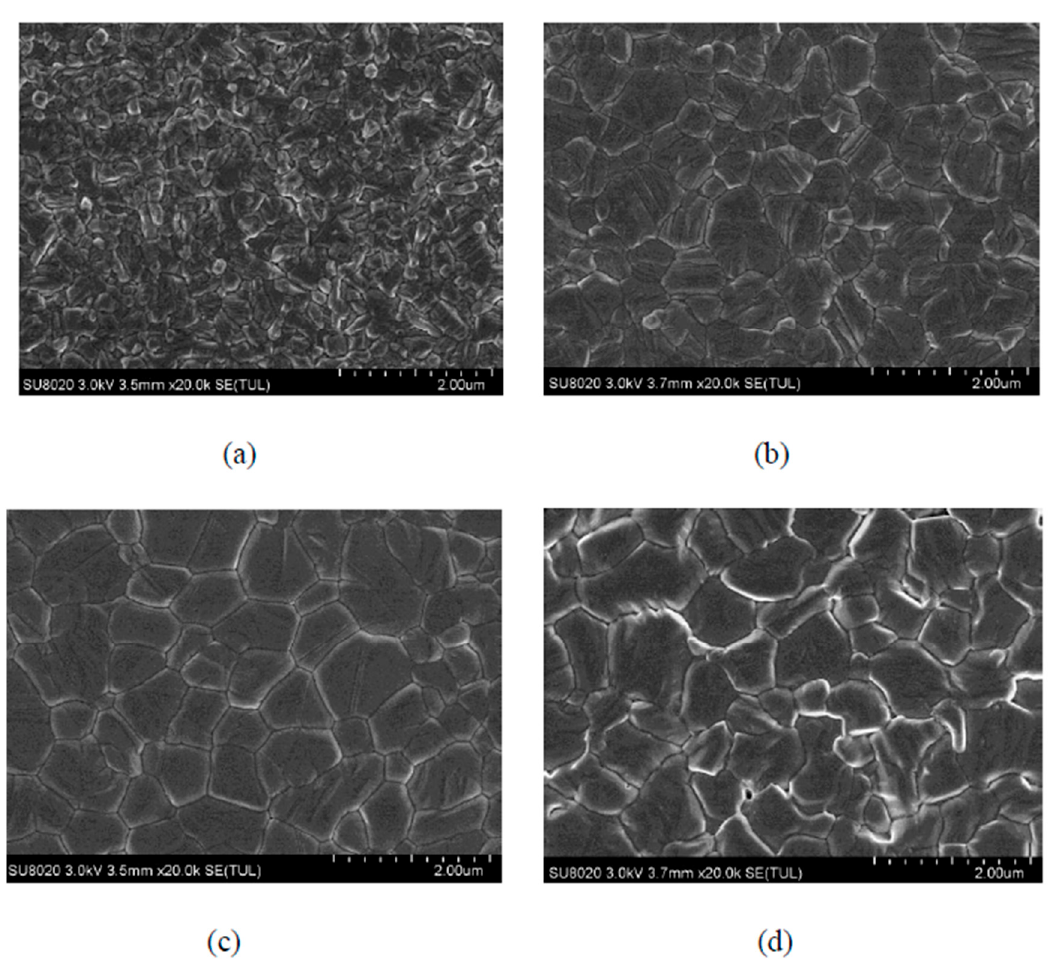
Figure 1. SEM images of perovskite layer prepared with formamidine methylamine halide precursors solutions with concentrations of 40:4:4 ( a ), 50:5:5 ( b ), 60:6:6 ( c ), and 70:7:7 ( d ), respectively.